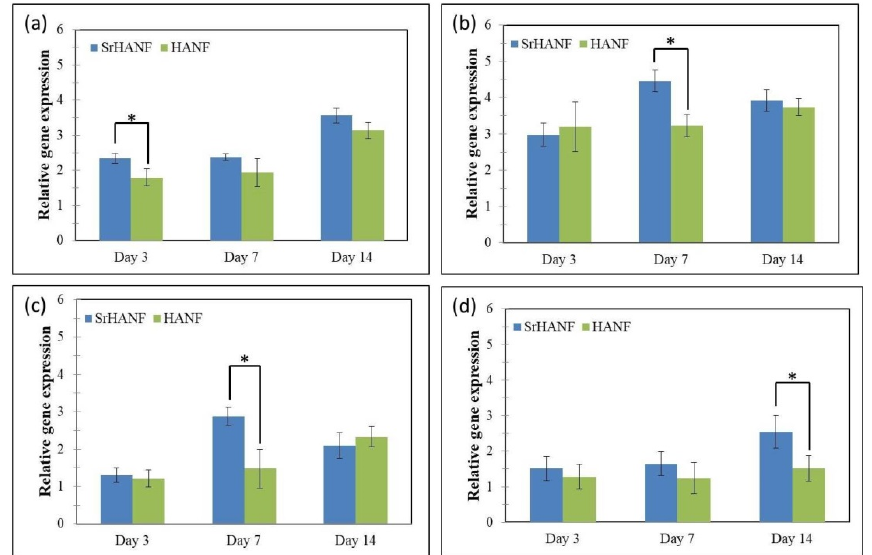
Figure 7. Matrices regulate the bone-associated genes expressed by MG63 osteoblast-like cells. Real– time PCR analyses of bone-associated genes expressed by MG63 osteoblast-like cells on SrHANF and HANF: ( a ) COLI , ( b ) RUNX2 , ( c ) BSP and ( d ) OCN levels after normalization to GAPDH . Data are shown as the fold change relative to the petri dish after three days of incubation. Statistical analysis comparing SrHANF and HANF. (*) Denotes a significant difference ( p < 0.05).